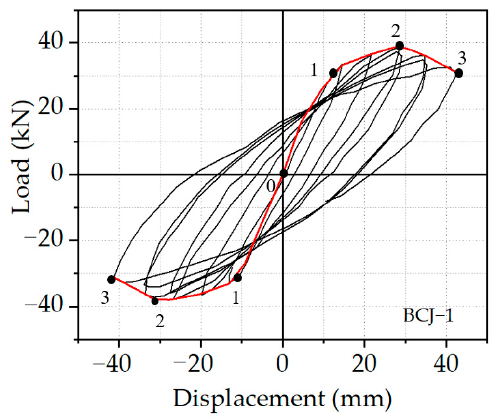
Figure 9. Hysteretic curves and feature points of specimen BCJ1.